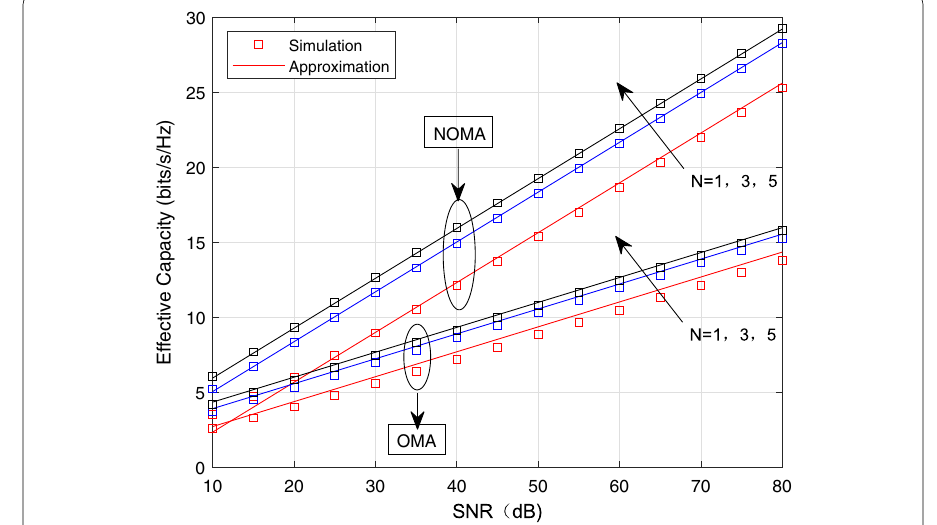
Fig. 3 The EC versus SNRs for NOMA and OMA at NU